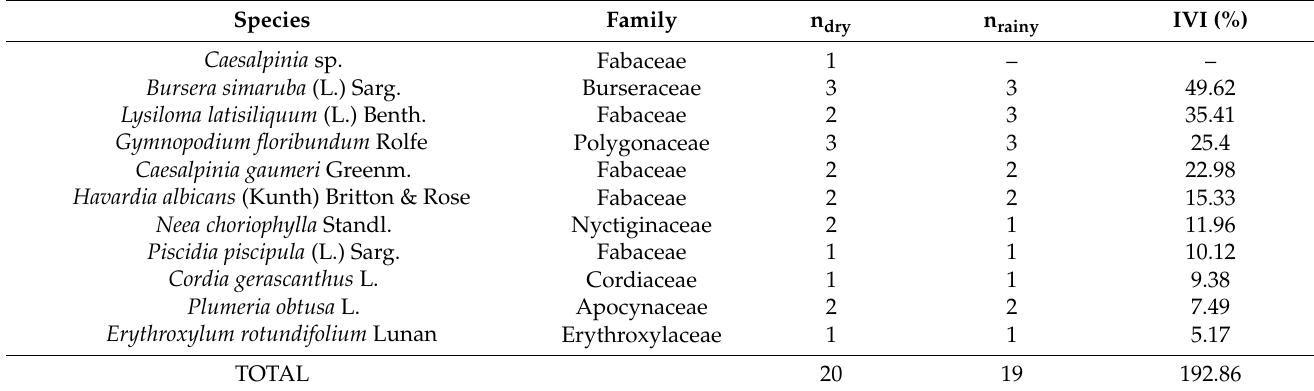
Table 1. Tree species selected to estimate transpiration and the importance value index (IVI) in the El Palmar tropical dry deciduous forest, Yucatan, Mexico. The species listed represent almost 193%; other species not listed here would account for the remaining 107%. Species Family n dry n rainy IVI